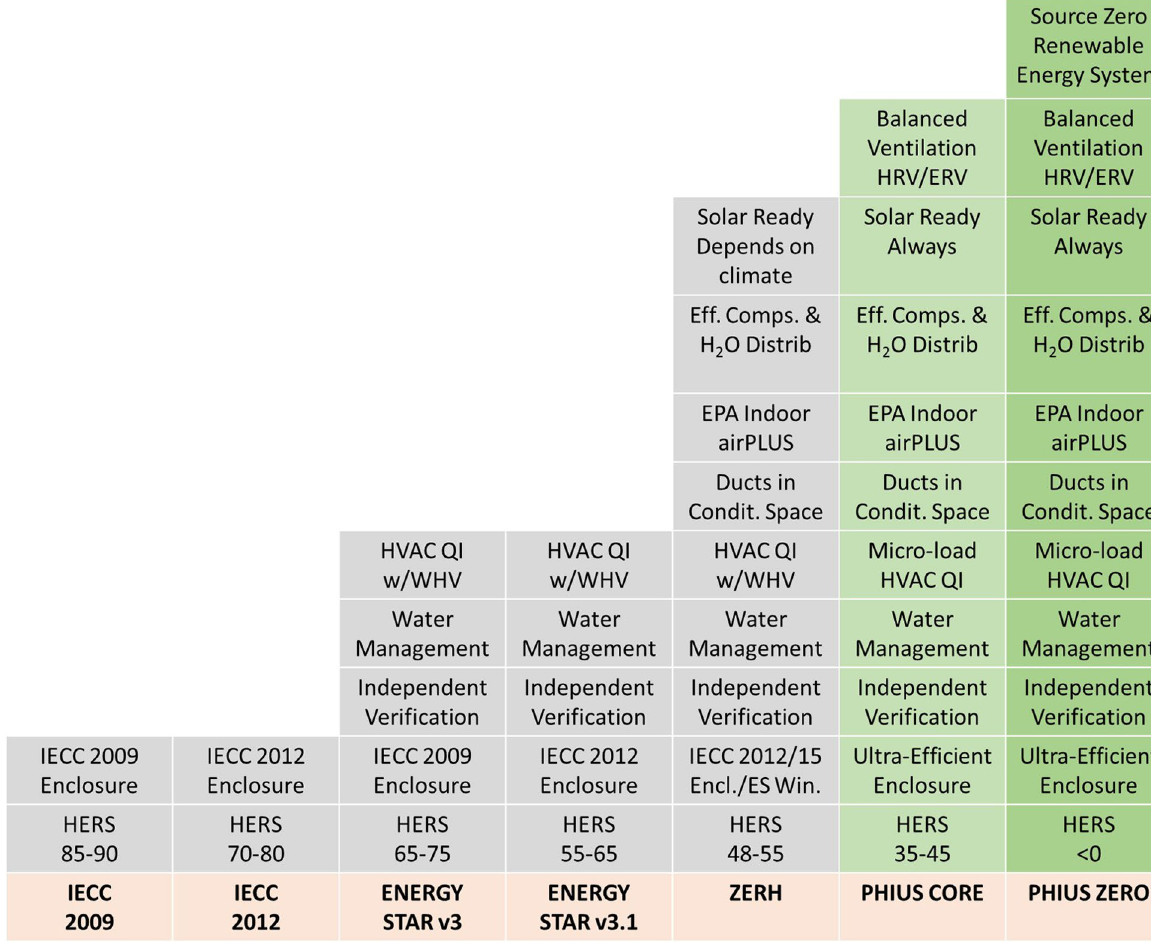
Fig. 8 Advancement of PHIUS CORE and PHIUS ZERO standards over previous building